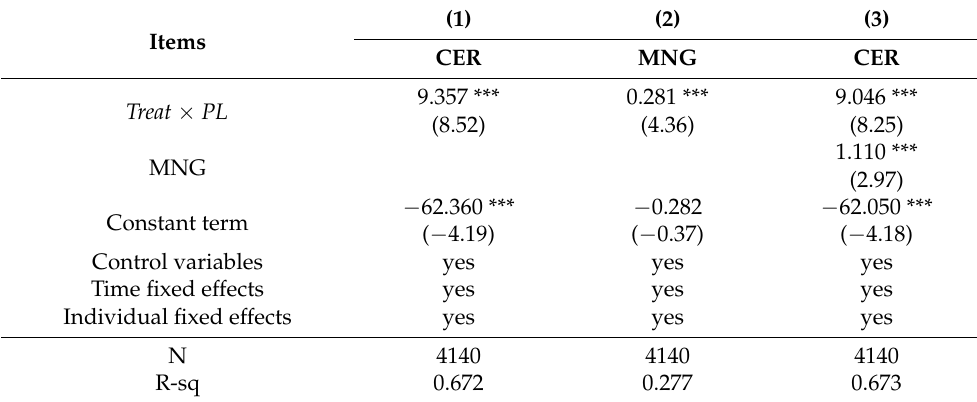
Table 5. Mediating effect results of environmental management disclosure